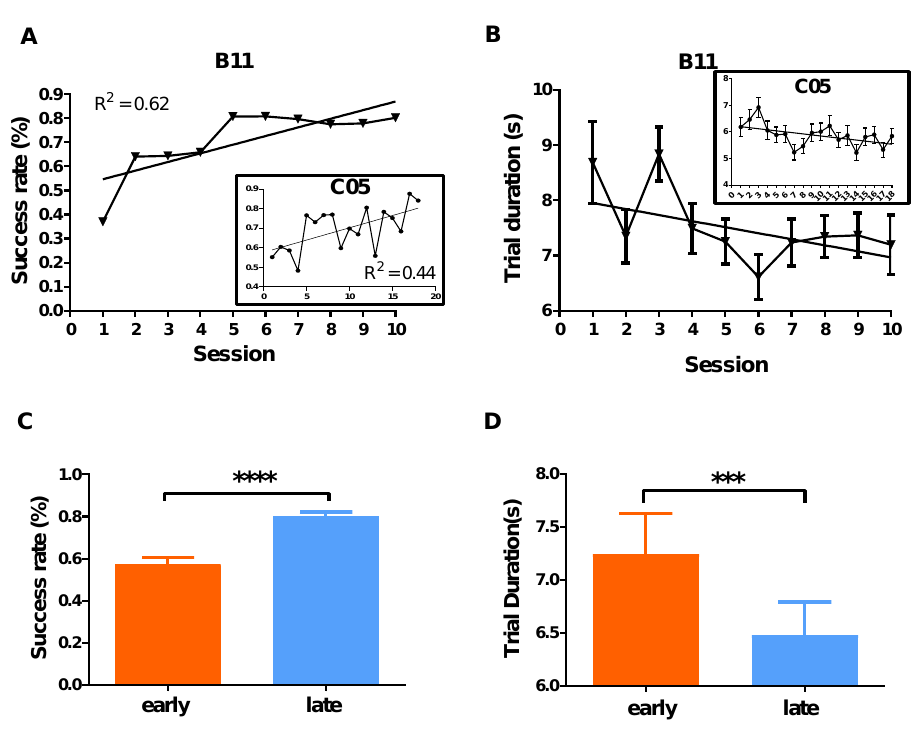
Figure 3. Proficiency increased in performing the BMI-based task. ( A ) The success rate exhibited a growing trend over the course of learning (linear fitting test to determine whether slope was significantly greater than zero: B11: p = 0.005; C05: p = 0.008). ( B ) The trial duration was reduced over the course of learning (linear fitting to account for sample size N and scatter among replicates and to test whether slope was significantly greater than zero: B11: p = 0.048; C05: p = 0.010). ( C ) Pronounced increase in the success rate from the early phase to the late phase, pooling over two subjects. One- tailed Mann–Whitney test, early < late, p < 0.0001. ( D ) Significant shortening in trial duration from the early phase to the late phase, pooling over two subjects and all trials (Mean ± SEM), F(1,1729) = 12.78, p = 0.0004. Interaction between two factors: F(7,1729) = 1.14, p = 0.3338. *** p < 0.001, **** p <